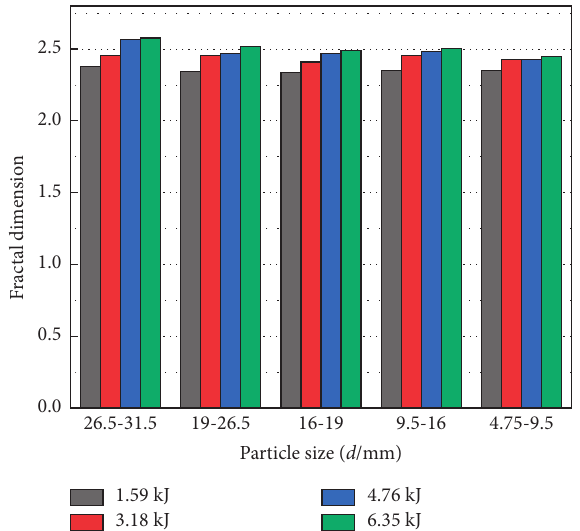
Figure 14: Comparison of parting dimensions of concrete recycled aggregate under different impact